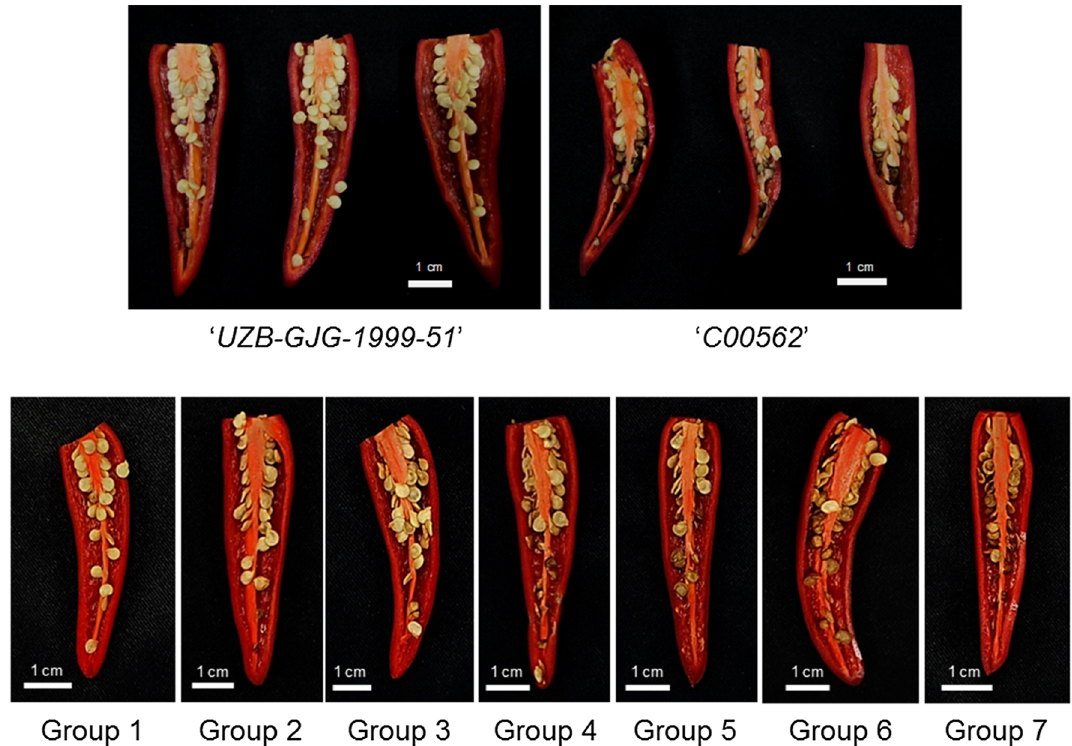
Figure 1. Seed browning appearances of ‘ UZB-GJG-1999–51 ’, ‘ C00562 ’ (upper pictures), and F 2 groups (bottom pictures) after chilling at 2 °C for 3 weeks. The groups were designated as Group 1 through Group 7, with seed browning rates being 0–10%, 10–20%, 20–30%, 30–40%, 40–50%, 50–60%, and > 60%, respectively. The pictures in the upper panel were published as “Jasmonic acid and ERF family genes are involved in chilling sensitivity and seed browning of pepper fruit after harvest” by J. G. Lee, G. Yi, J. Seo, B. C. Kang, J. H. Choi, and E. J. Lee, 2020, in Scientific Reports, volume 10, Results section, Fig. 1. CC